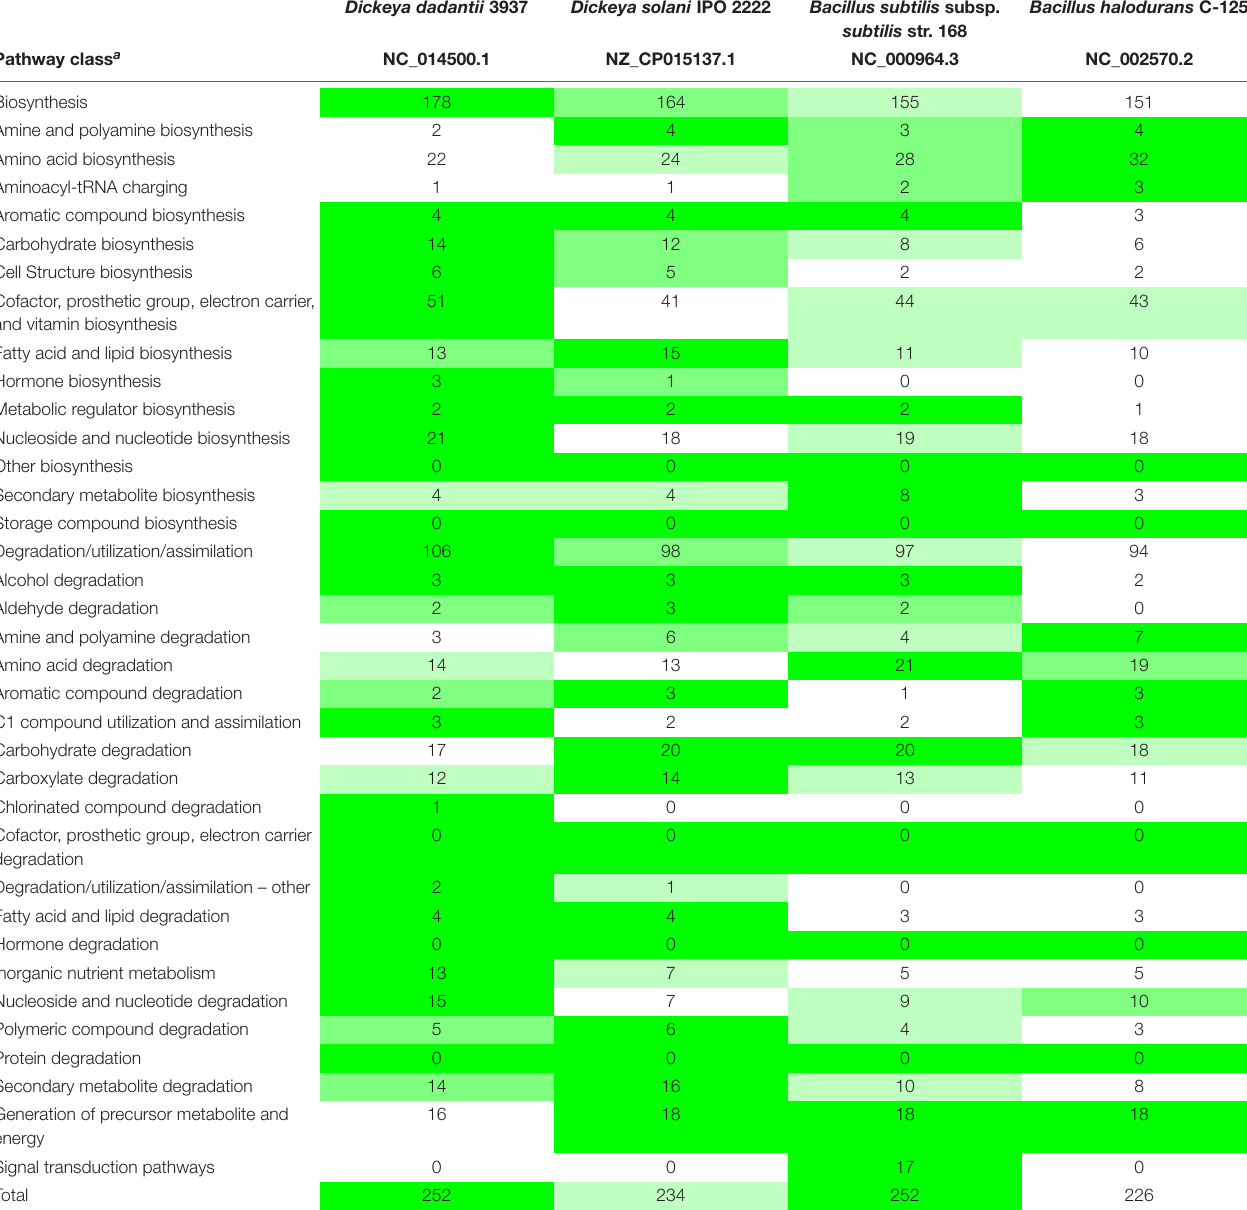
TABLE 3 | Analysis of metabolic pathways in the genomes of four pectinase producing